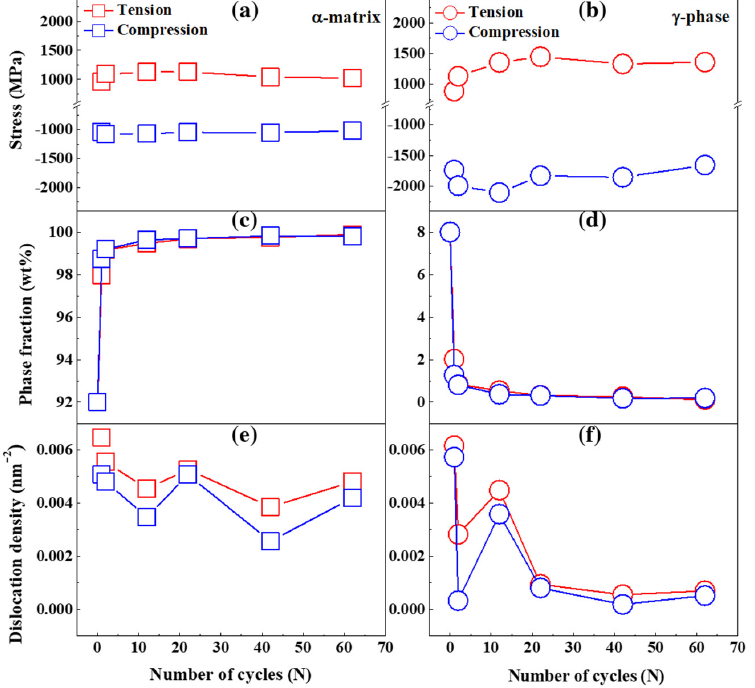
Figure 4. The microscopically individual stresses of the ( a ) α -matrix and ( b ) γ -phase; the phase fraction of the ( c ) α -matrix and ( d ) γ -phase; the dislocation density of the ( e ) α -matrix and ( f ) γ -phase as a function of fatigue cycles.